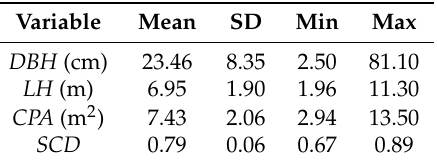
Table 1. Descriptive statistics of tree variable measurements (SD, standard deviation; DBH, diameter at breast height; LH, LiDAR-derived tree height; CPA, crown projection area; and SCD, stand canopy